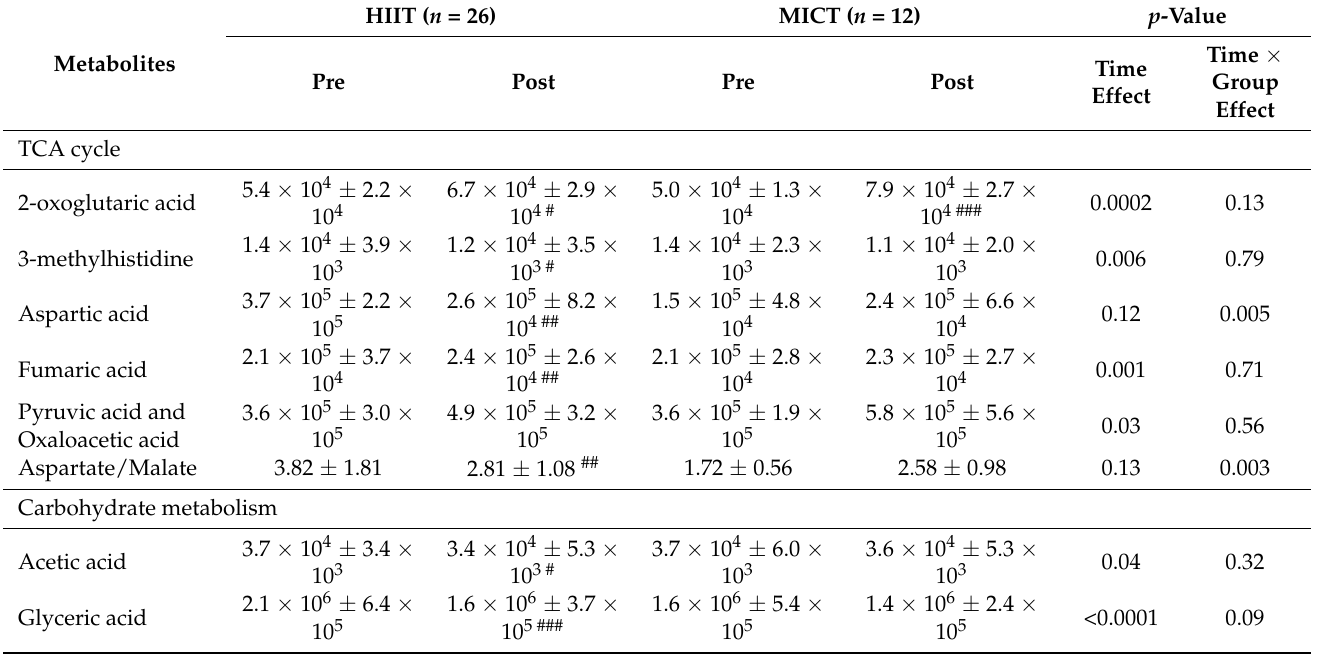
Table 2. Effect of a 12-week High-Intensity Interval Training (HIIT) and Moderate-Intensity Continu- ous Training (MICT) on metabolites of tricarboxylic acid (TCA) cycle, carbohydrate metabolism and amino acid metabolism in obese older